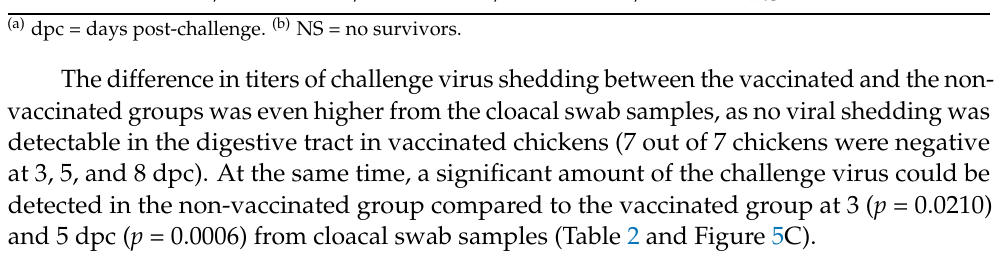
Table 2. Frequency of isolation of challenge virus in vaccination groups. Number of Viral Shedding Chickens (Positive/Total) Group 3 dpc (a) 5 dpc 8 dpc Oral Cloacal Oral Cloacal Oral Cloacal